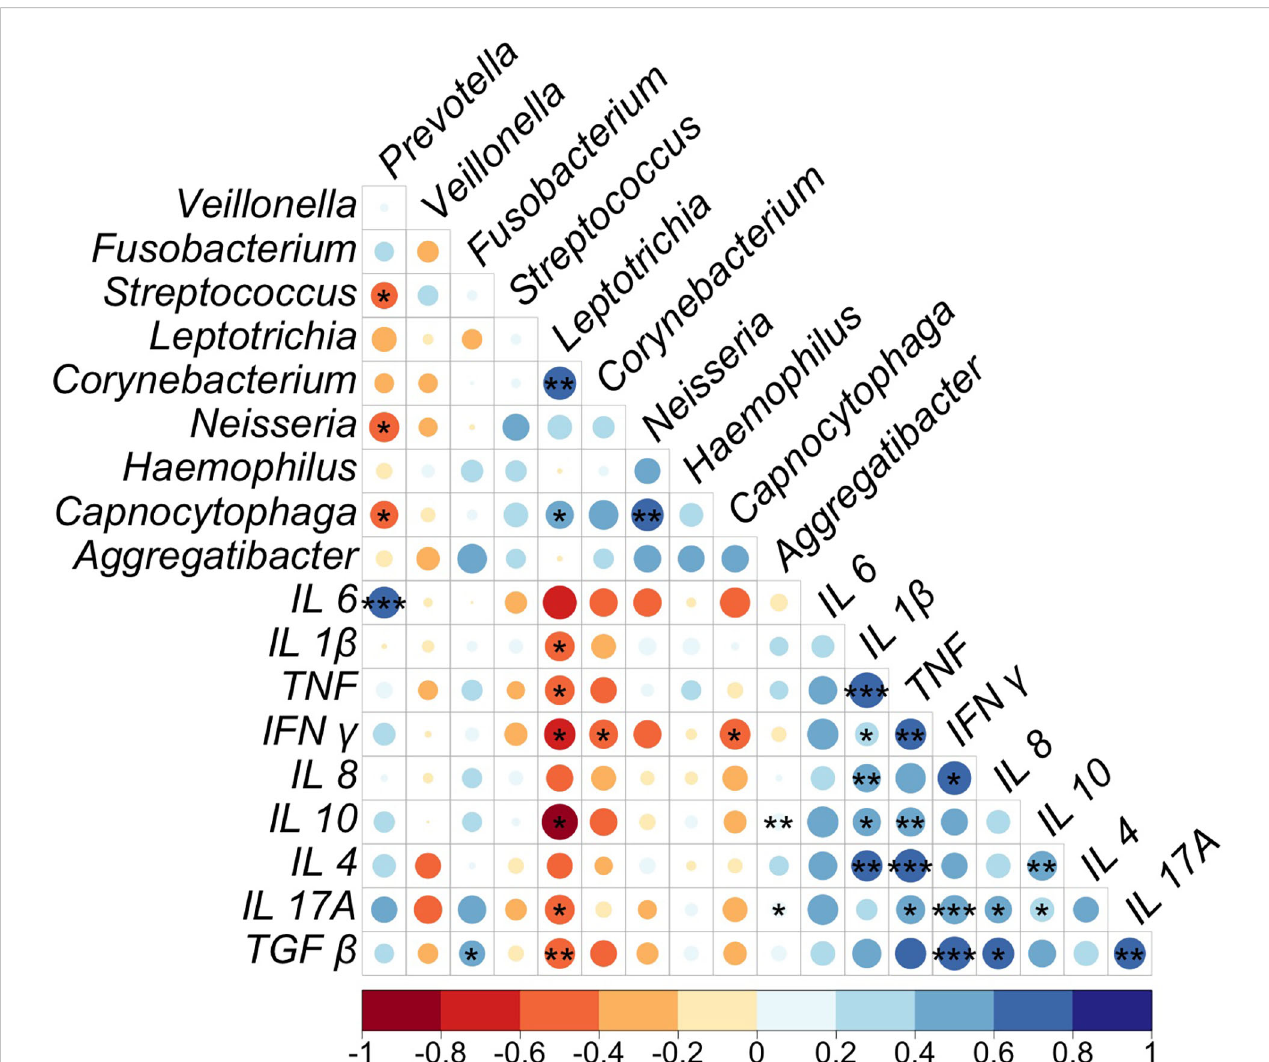
FIGURE 5 Spearman correlation test of oral microbiota diversity and serum cytokines concentration in STEMI patients; p value: *p ≤ 0.05, **p ≤ 0.01, ***p ≤